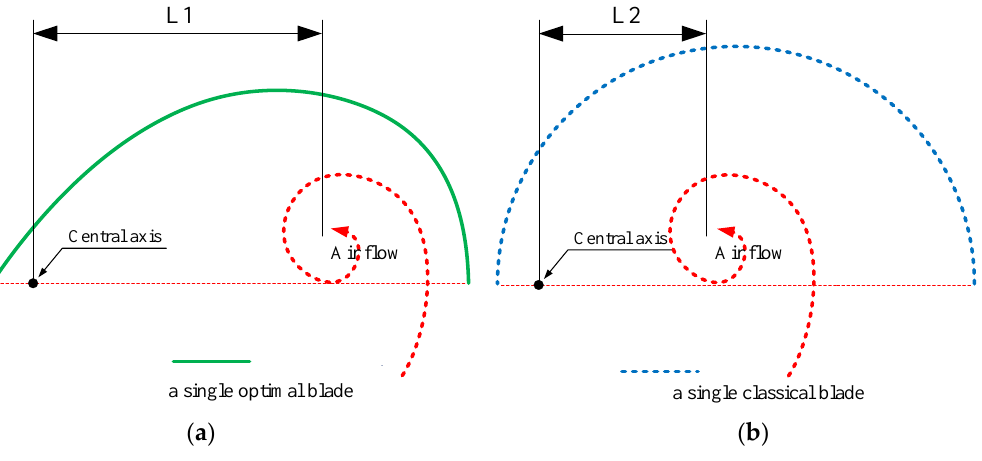
Figure 15. Simplified air flow diagram acting on the classical Savonius and the optimal Savonius.